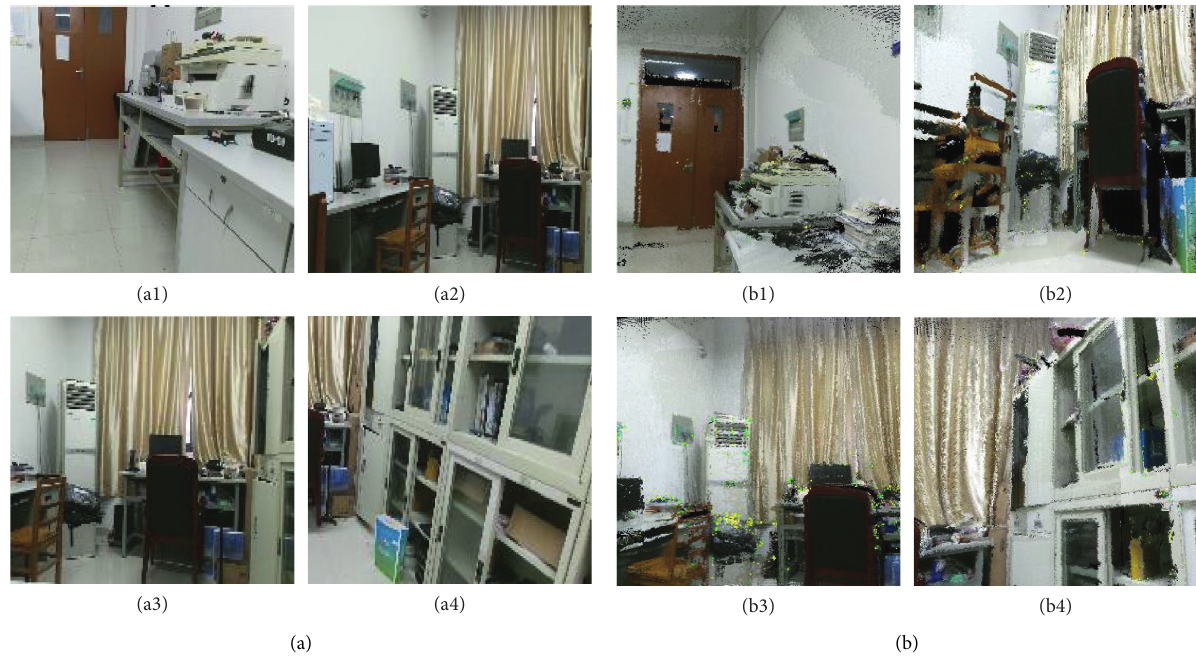
Figure 2: Key frame reconstruction in submaps. (a) Local image of four segments of experiments. (b) Local image of four segments of experiments after being